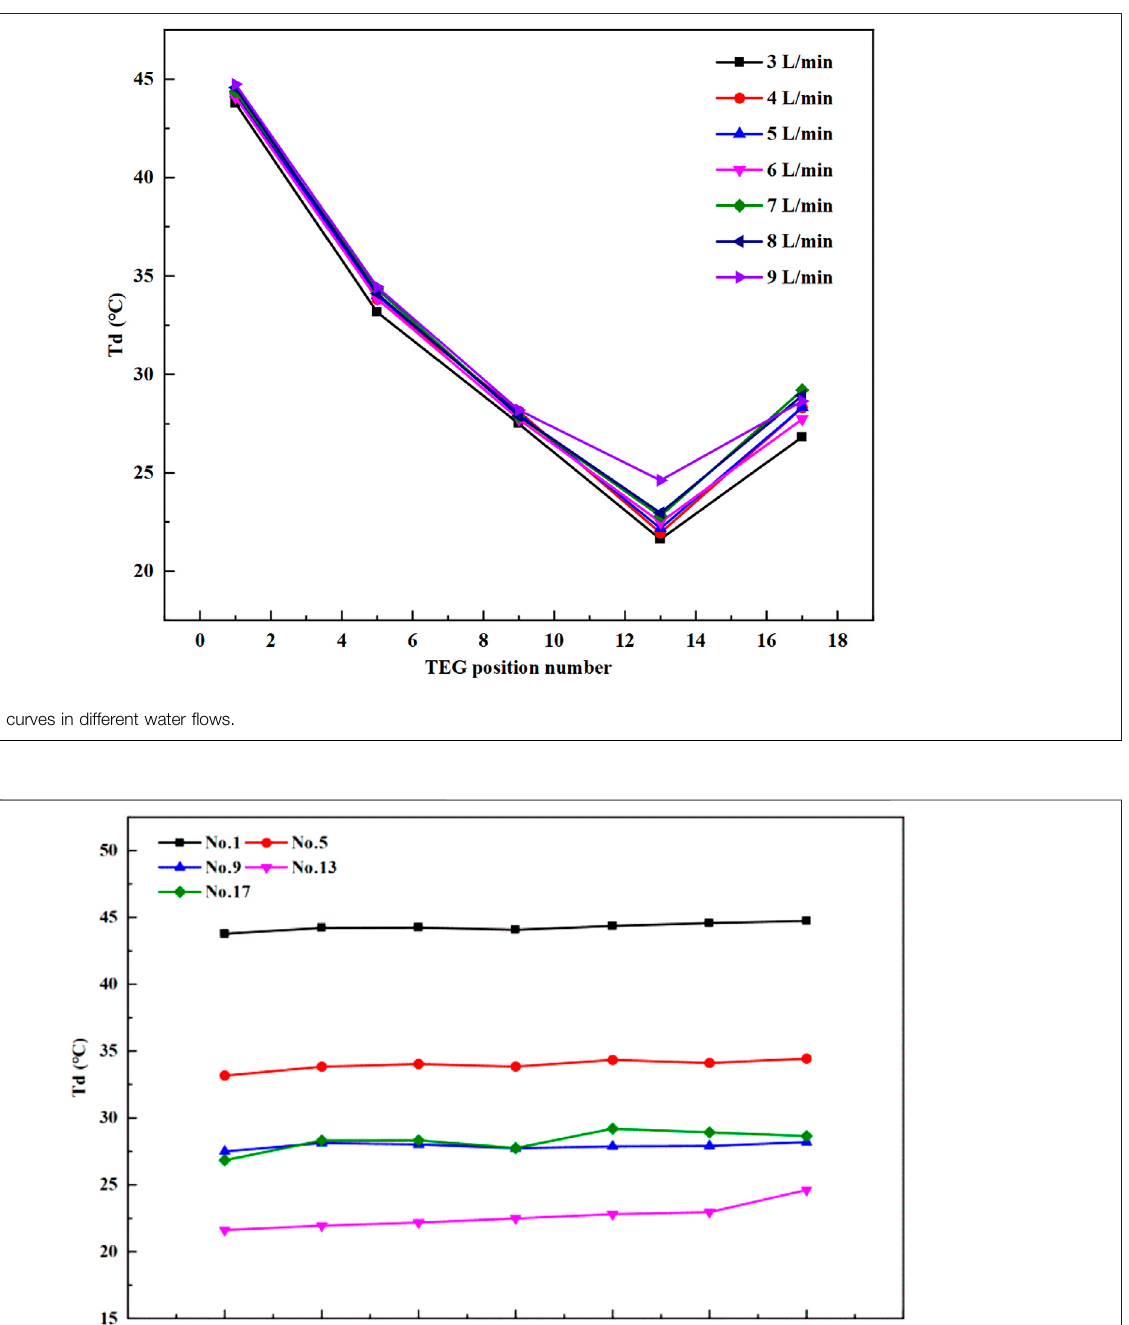
16.08 ° C. Due to the temperature difference between the water